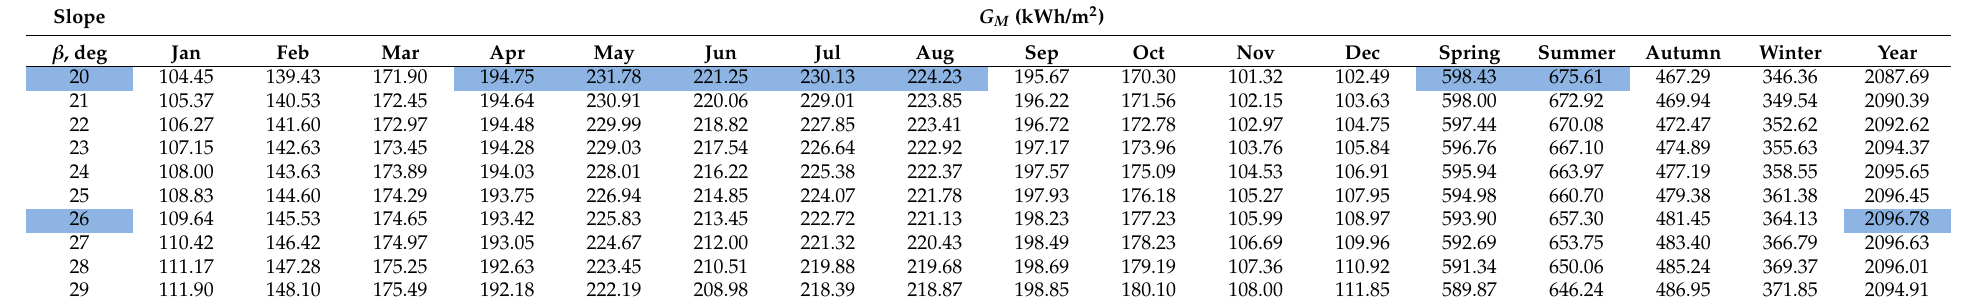
Table 16. Monthly total energy received by an inclined surface for each month of the year and for different slope angles ( β ) ranging from 20 ◦ to 32 ◦ at Athalassa. The optimum slope angles for each month are